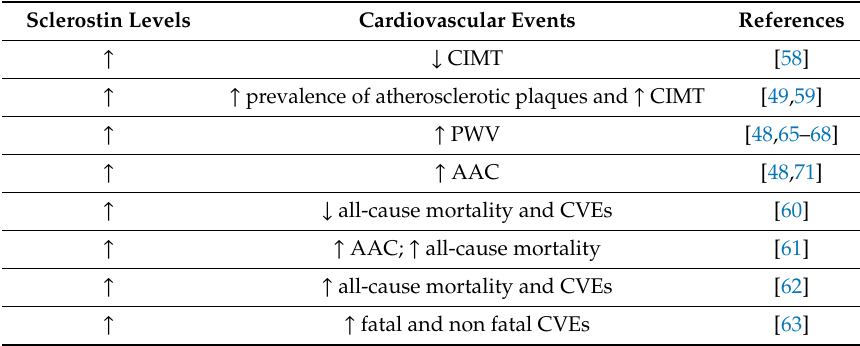
Table 2. Association between sclerostin levels and cardiovascular